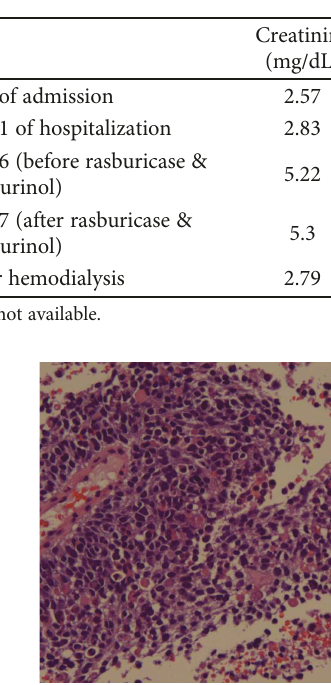
Figure 1: CT abdomen and pelvis without contrast showing a mass attached to the right lobe of the liver and peritoneal ascites. (a) Axial section. (b) Coronal section. Table 1: Creatinine, uric acid, electrolyte, and LDH values of the patient at di ff erent time point.